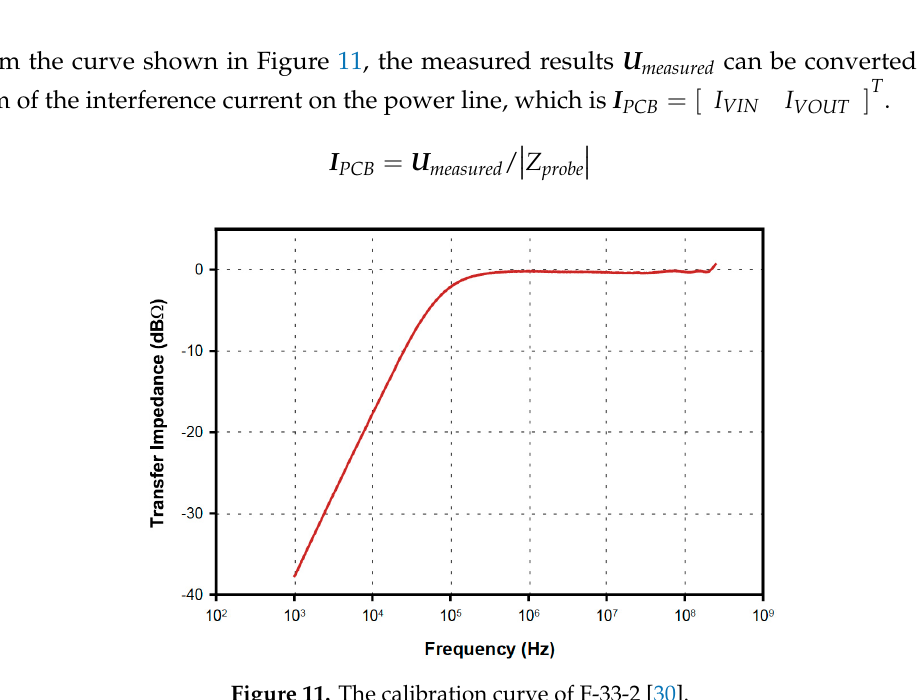
Figure 11. The calibration curve of F-33-2 [30].